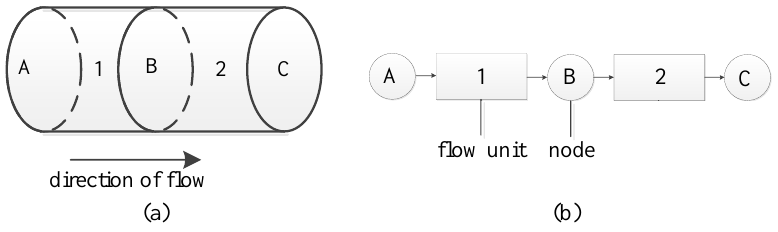
Figure 14. Calculation principle of flowing unit: ( a ) Schematic diagram of the divided flow channel. ( b ) Abstracted computing